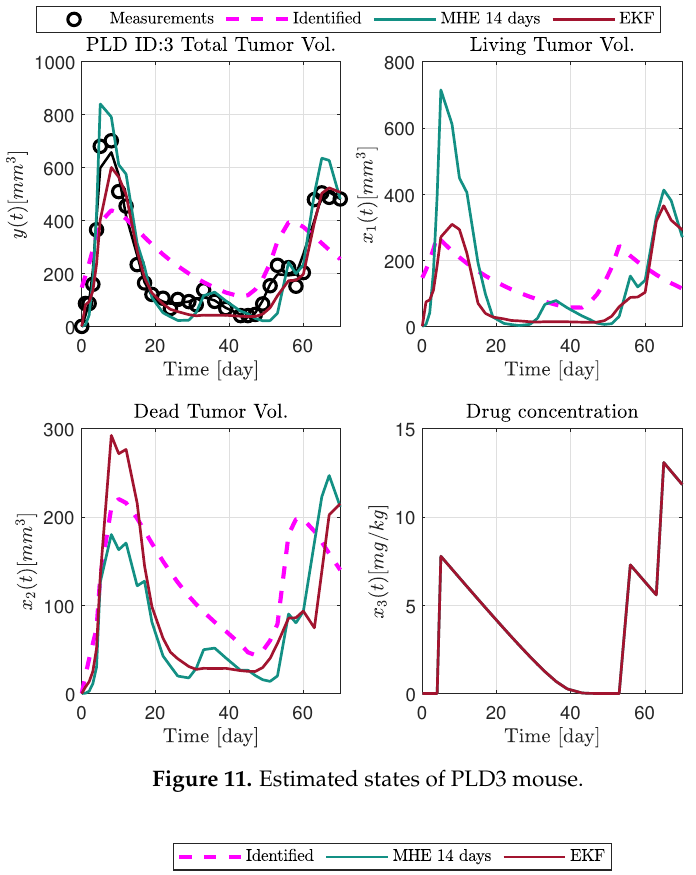
Figure 11. Estimated states of PLD3 mouse.